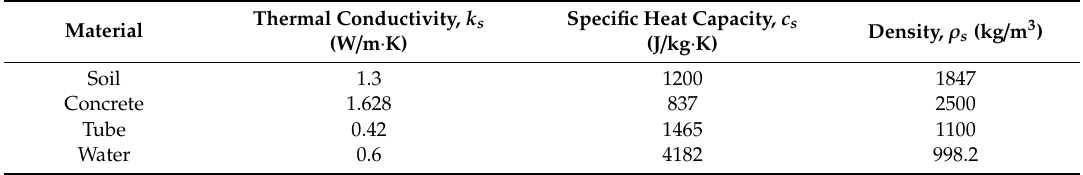
Figure 2. Tube positions at the pile head section.